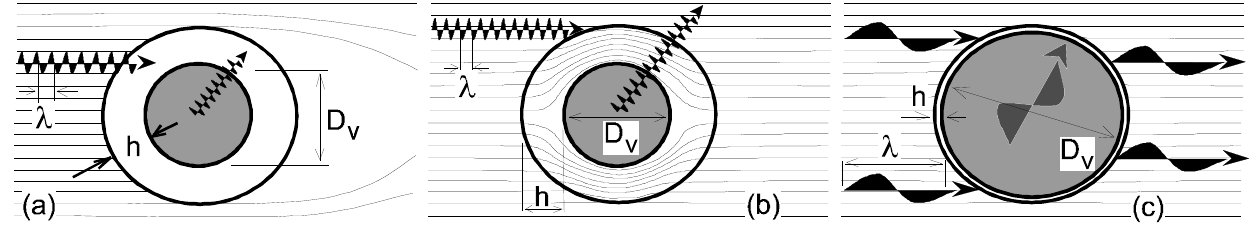
Figure 1. Traditional thick passive coating for absorption ( h >> λ ) suppresses the body's radiation and its back scattering, but does not suppress forward scattering (a); (cloaking [3- 7]) thick ( h >> λ ) passive coating, constructed from metamaterials, makes the body transparent, but does not suppress the body's radiation (b); thin ( h << λ ) active coating, which suppresses both scattering to the back and forward scattering and radiation of the protected body. The horizontal parallel lines on the left side of (a-c) represent the power flux